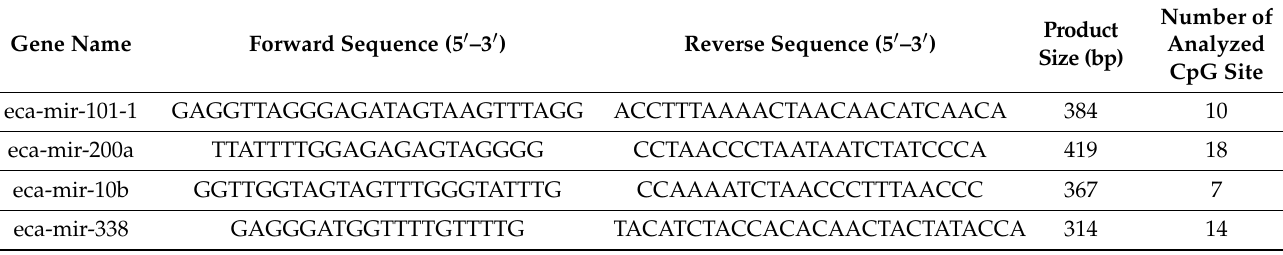
Table 2. BSP primer sequences used in the study.